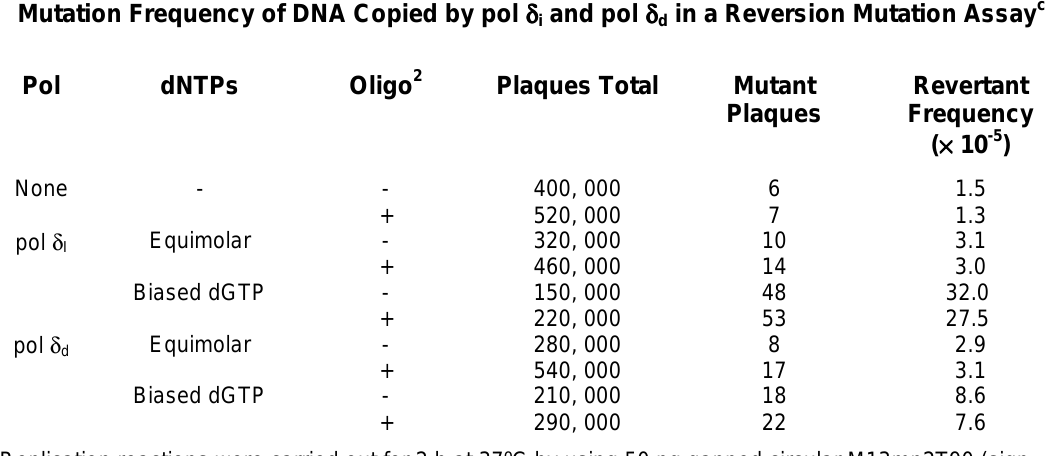
and pol δδδδ in a Reversion Mutation Assay c i d